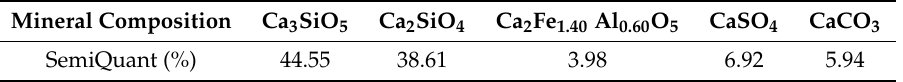
Table 3. Mixture design of the FAGC.